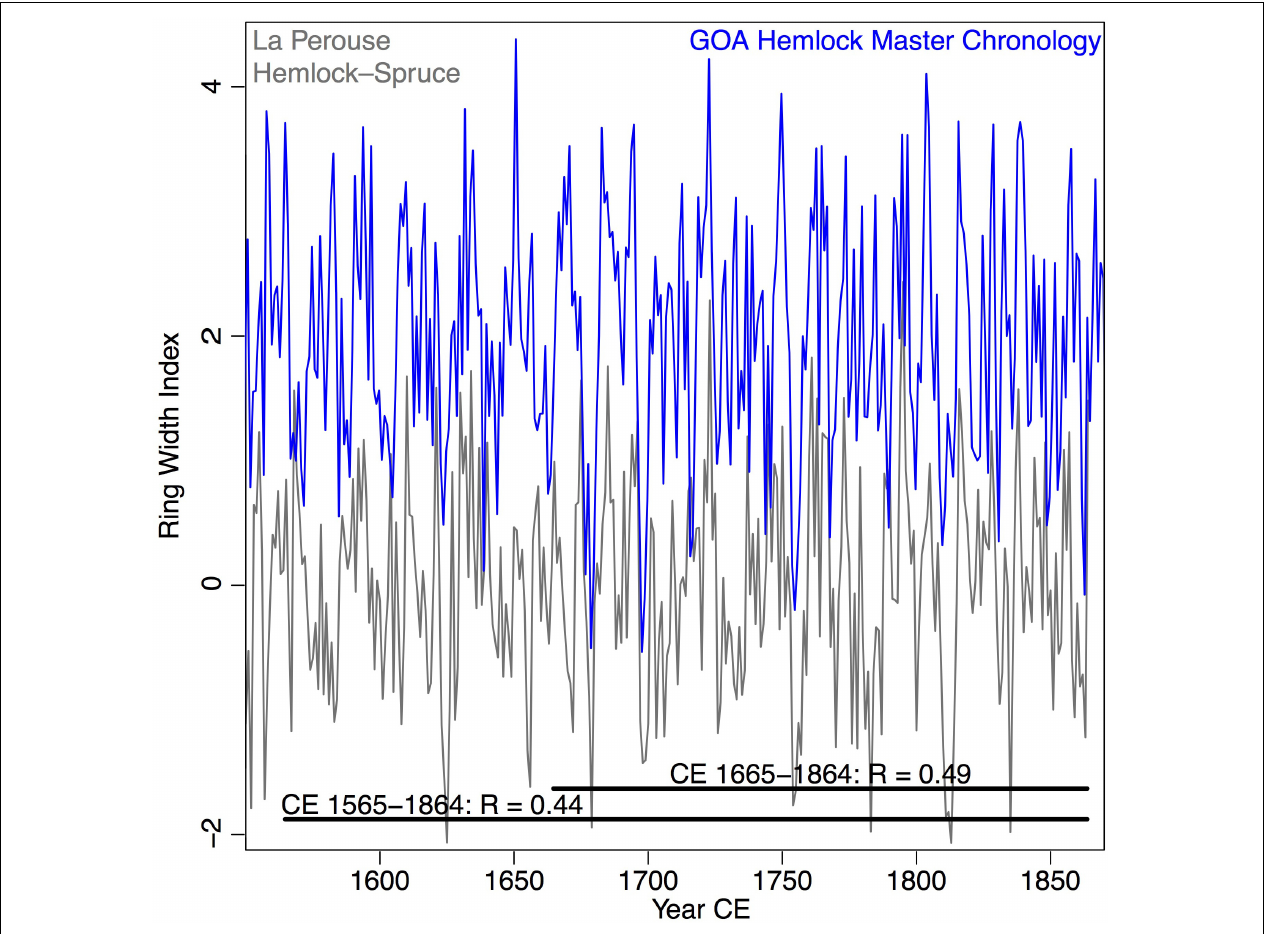
FIGURE 3 | Master ring-width chronology of the La Perouse western hemlock and Sitka spruce trees (gray; bottom) compared with the master chronology of living hemlock and spruce (blue; top) from the Gulf of Alaska region (Wiles et al., 2014; see locations in Figure 1 ).